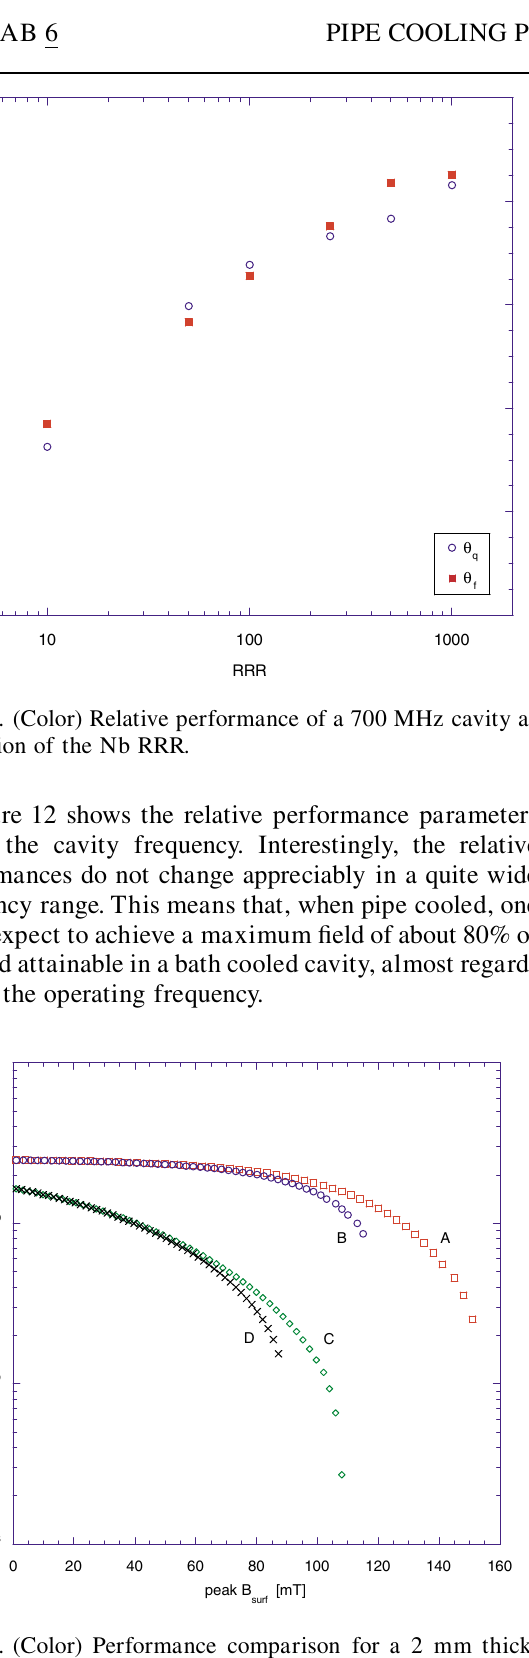
FIG. 11. (Color) Performance comparison for a 2 mm thick, bulk Nb cavity whose dimensions were scaled to operate at 500 MHz and 3 GHz. RRR (cid:3) 300 for all curves. Curve ( A ): bath cooled, 500 MHz; ( B ): pipe cooled, 500 MHz; ( C ): bath cooled, 3 GHz; ( D ): pipe cooled, 3 GHz.